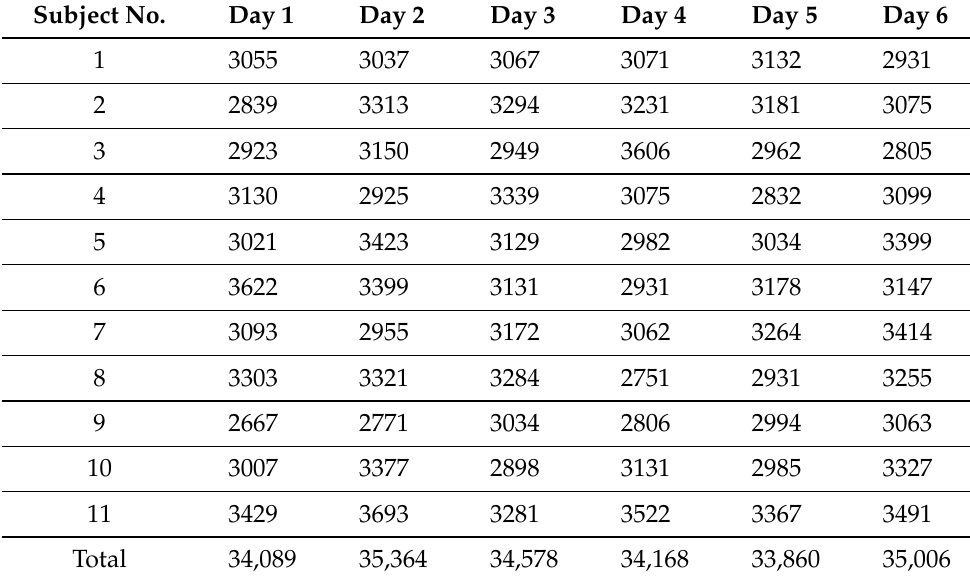
Table 3. The number of beat data for each subject from Day 1 to Day